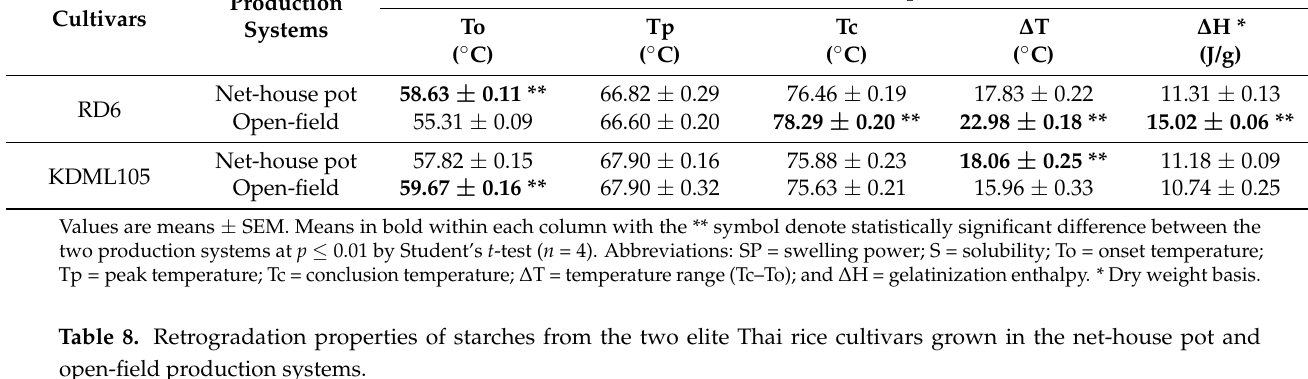
Table 7. Gelatinization properties of starches from the two elite Thai rice cultivars grown in the net-house pot and open-field production systems.